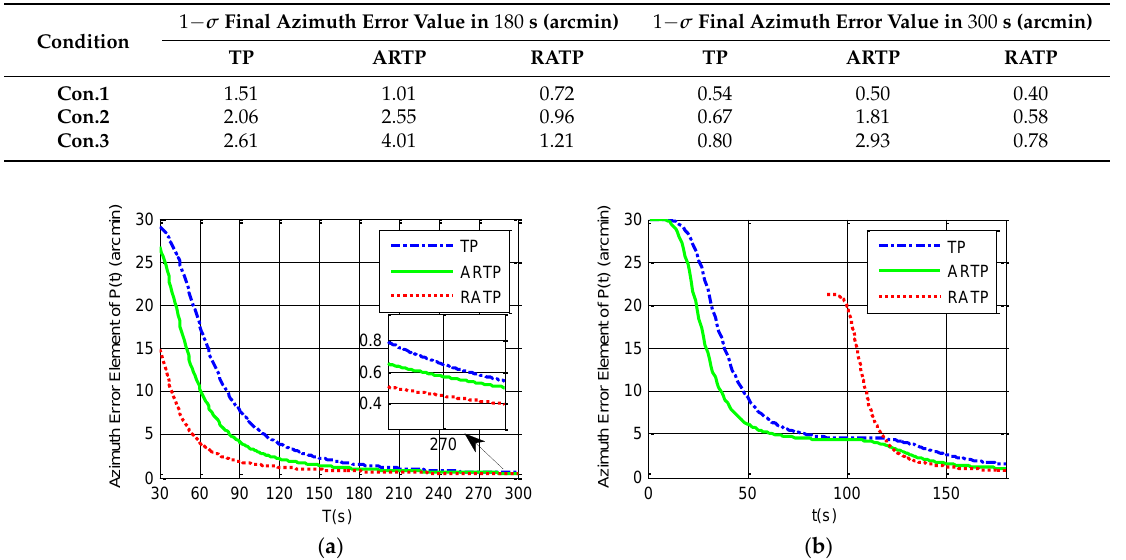
Figure 1. Simulation results under stationary condition. ( a ) 1 − σ final azimuth error when the total alignment time T changes from 30 to 300 s. ( b ) Azimuth error time history curve when the total alignment time is 180 s.